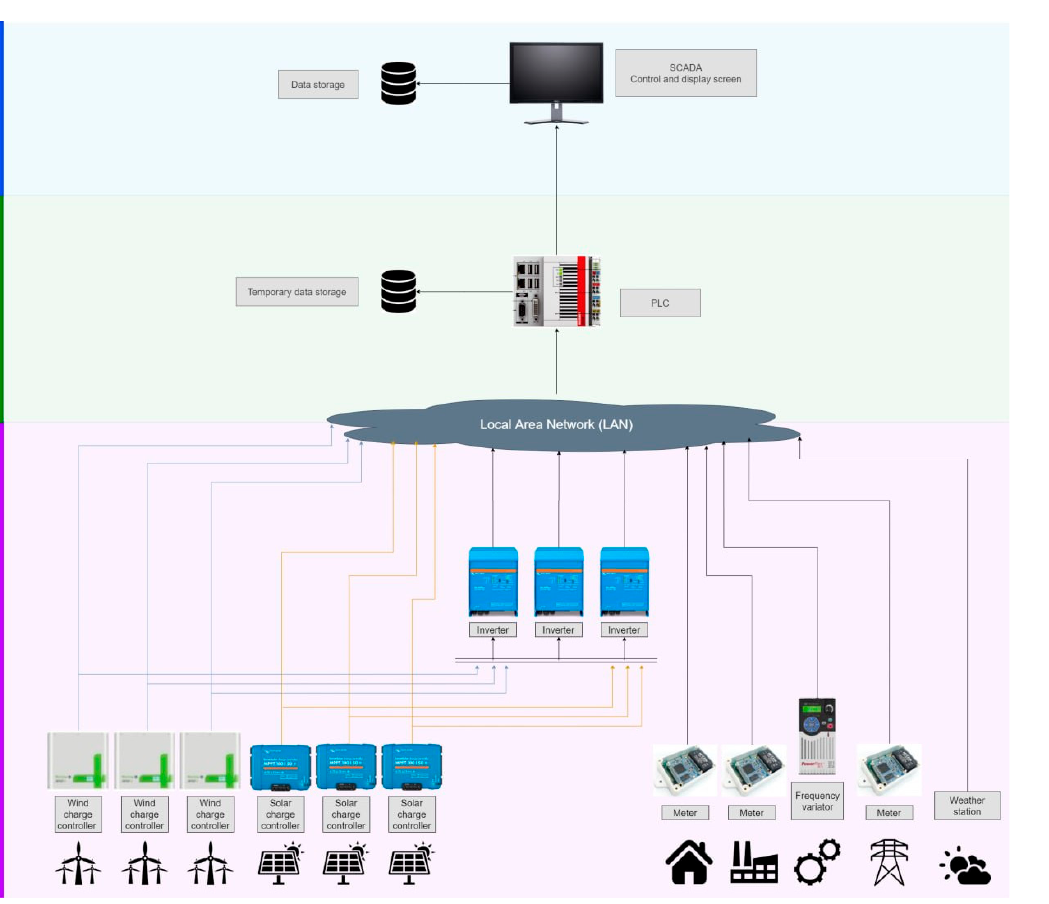
Figure 3. Data flow map for communication